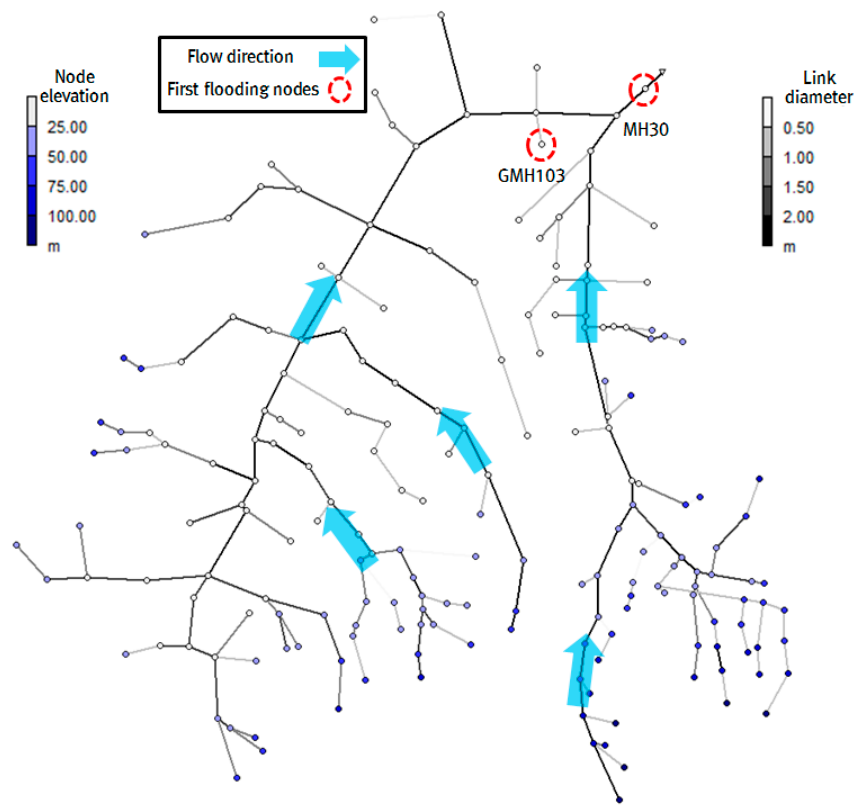
Figure 5. Drainage network of the target watershed.